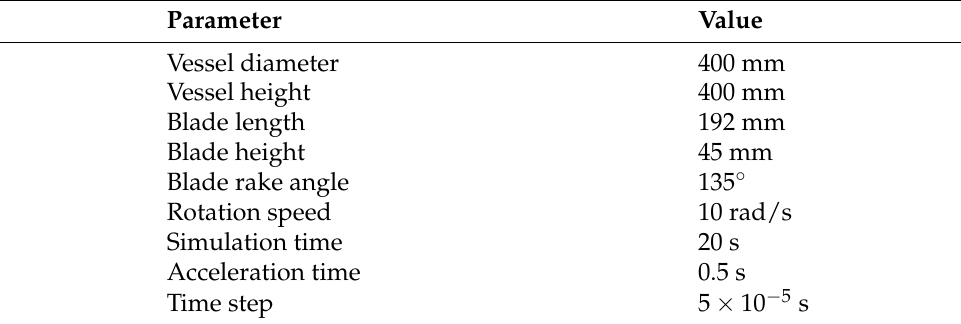
Figure 7. Snapshot of the high shear mixing simulation mixer. Table 3. Geometric parameters of the high shear